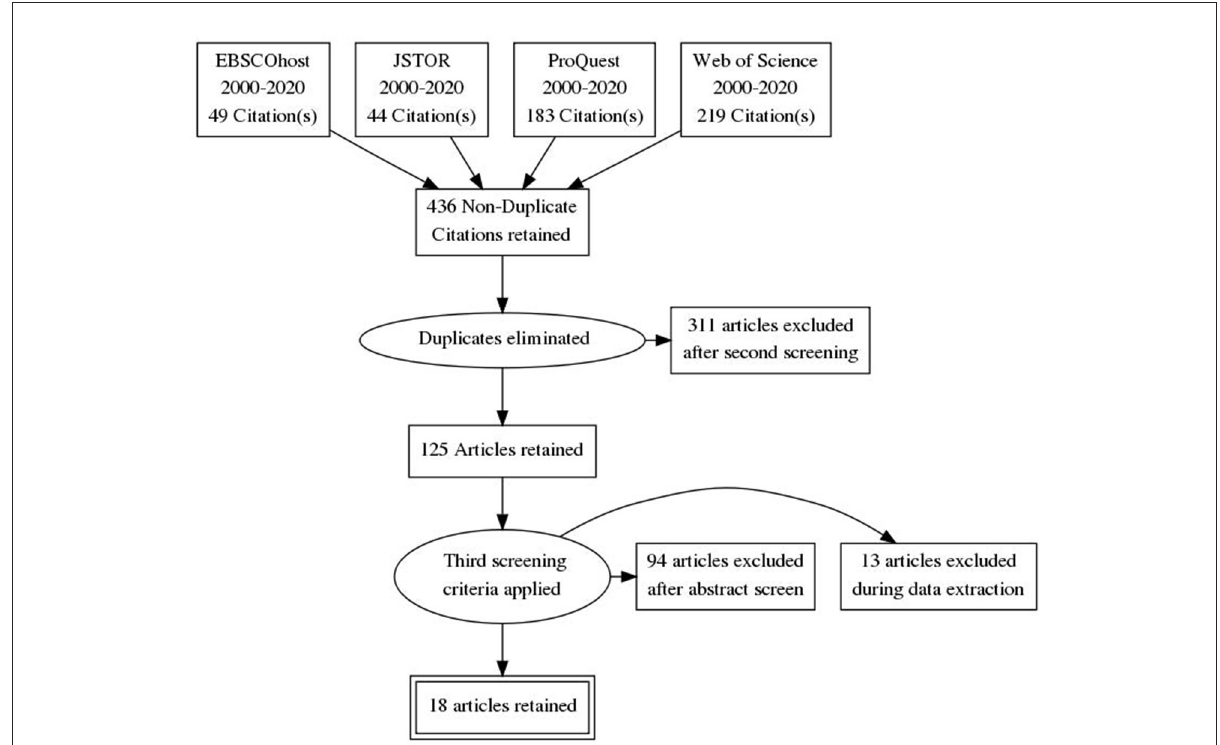
FIGURE1 Screening process flowchart. Figure created with PRISMA Flow Diagram Generator by Toronto Health Economics and Technology Assessment Collaboration (http://prisma.thetacollaborative.ca/).